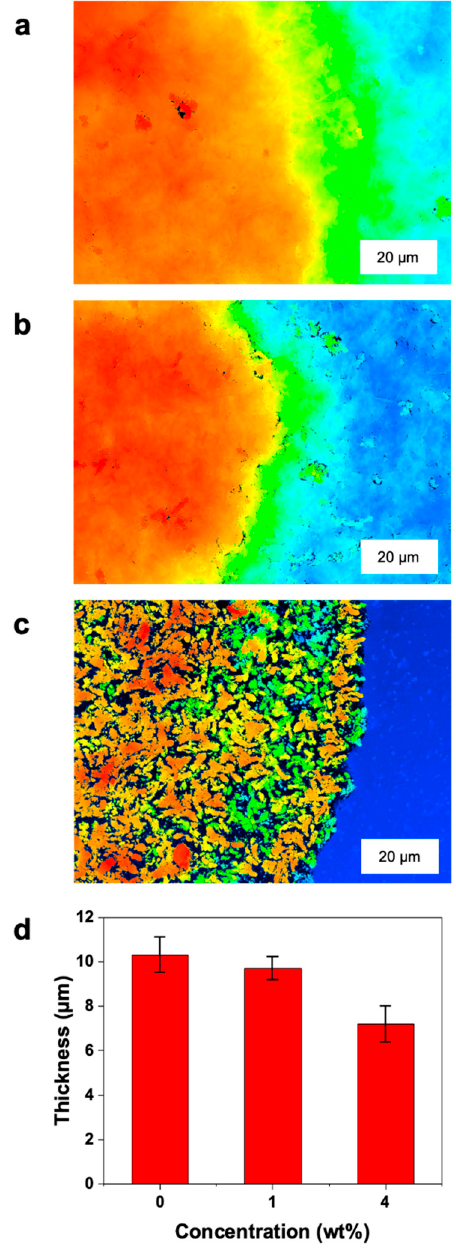
Figure 4. Confocal laser scanning microscopy (CLSM) images of rhombohedral CaCO 3 -SF hybrid films obtained in 4 wt% ( a ) and 1 wt% ( b ) SF hydrogels and in the absence of SF hydrogels ( c ). The thickness statistics based on the above CLSM images is summarized in the chart ( d ), where 30 positions each were used for